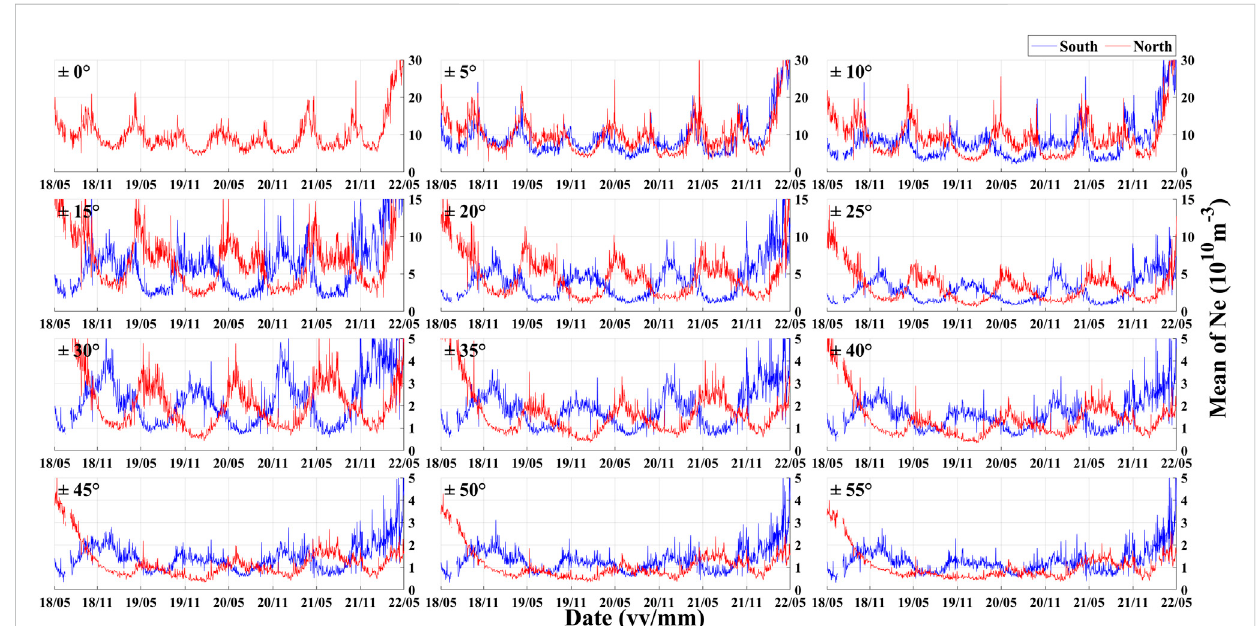
FIGURE 5 Temporal variation of daytime Ne in different Mlats ranges. Results are presented from the equator to ±55 ° Mlat with 5 ° intervals. Each subplot represents the daily mean Ne variation at different Mlats range. The blue line represents data in the southern hemisphere and the red line represents data in the northern hemisphere.